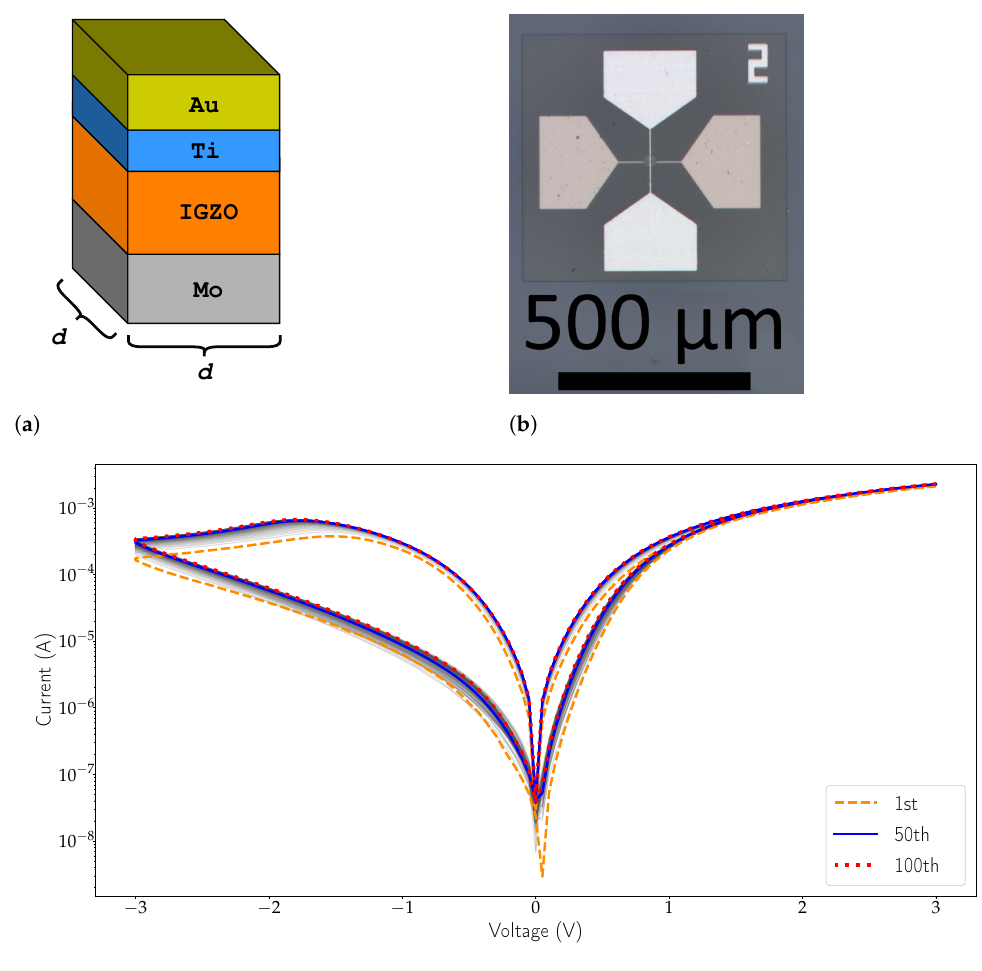
Figure 2. ( a ) Diagram of the IGZO memristor layers. The width of the device is represented by d , with the DUT having d = 2µm (figure is not to scale). ( b ) Micrograph of the fabricated amorphous IGZO devices showcasing a cross-point structure with a 4µm 2 area. The numbers represent the width of the device in µm. ( c ) Logarithmic I-V characteristic of a 4µm 2 IGZO memristor subjected to 100 endurance